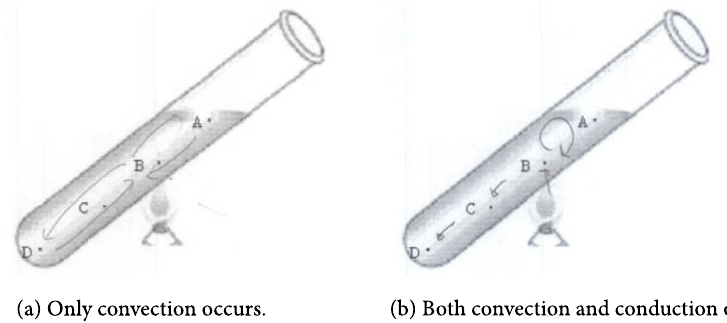
FIG. 4. Examples of the participants’ drawings of the heat transmission in Tube